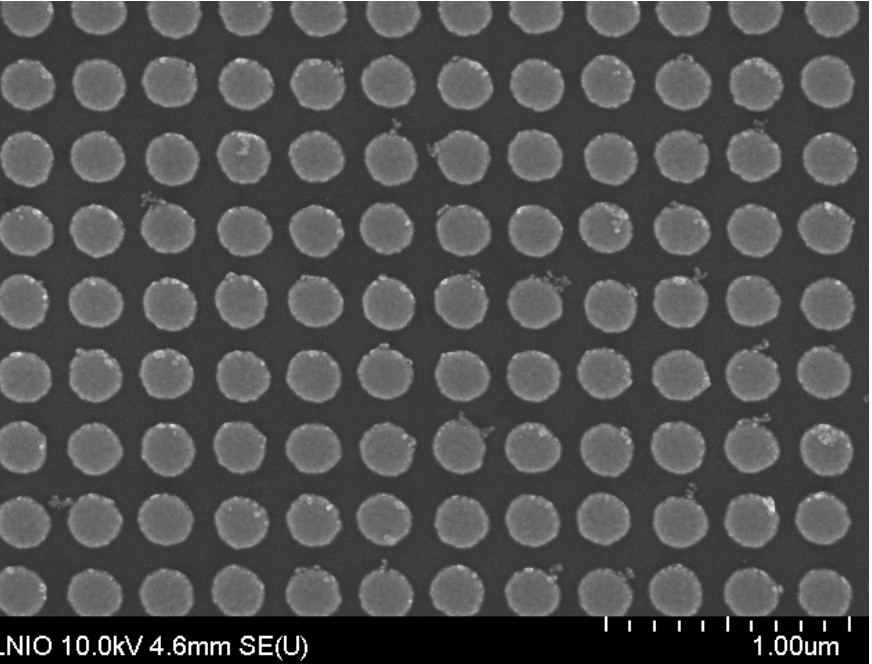
Figure 2. SEM image of gratings of monomers ( d = 200 nm) with vertical pitch ( Py ) of 300 nm and horizontal pitch ( Px ) of 400